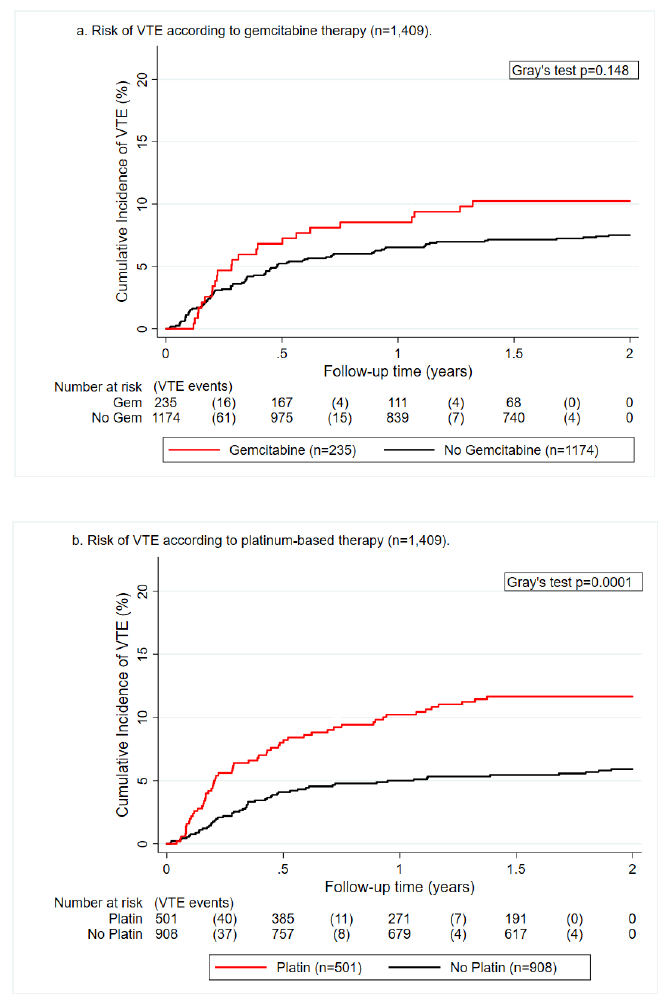
Figure 1. Cumulative incidence function of venous thromboembolism (VTE) risk according to gemcitabine ( a ) and platinum-based chemotherapy ( b ).